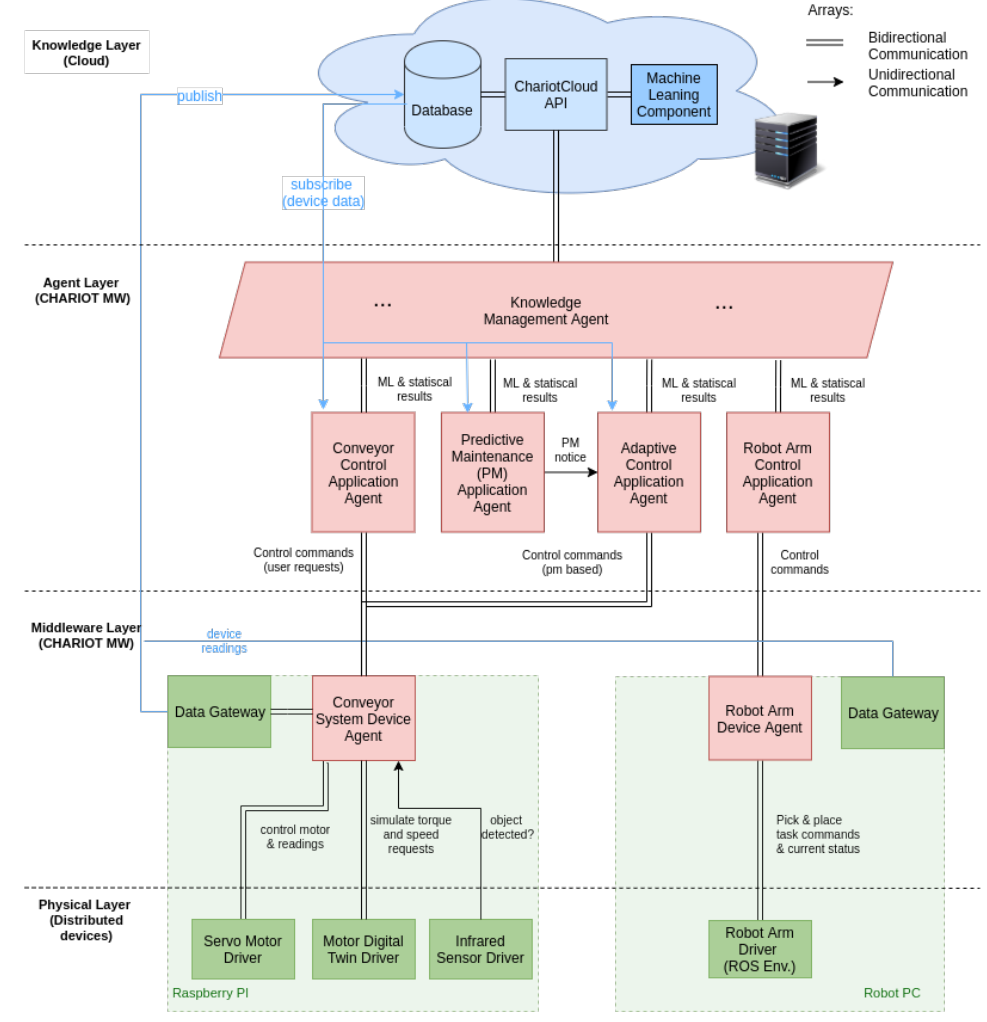
Figure 7. An IoT framework: CHARIOT project